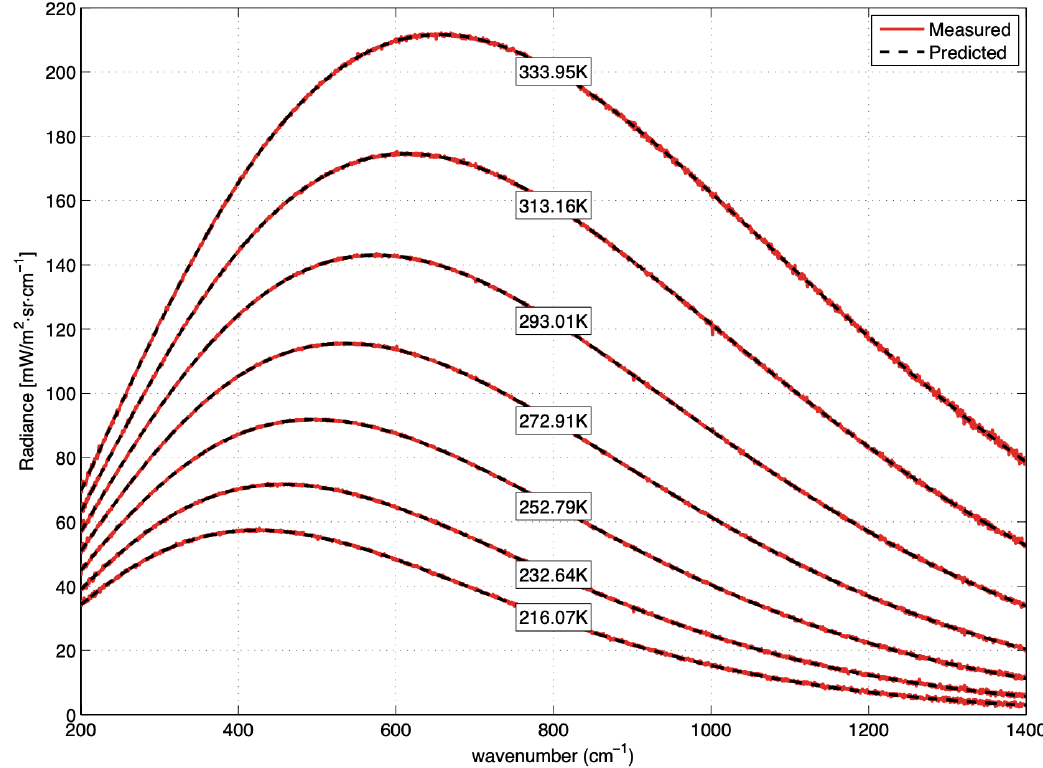
Figure 11. Radiance summary for the ARI DTGS detector calibration verification conducted under vacuum. The OARS was operated over a range of temperatures from approximately 216 K to 334 K.